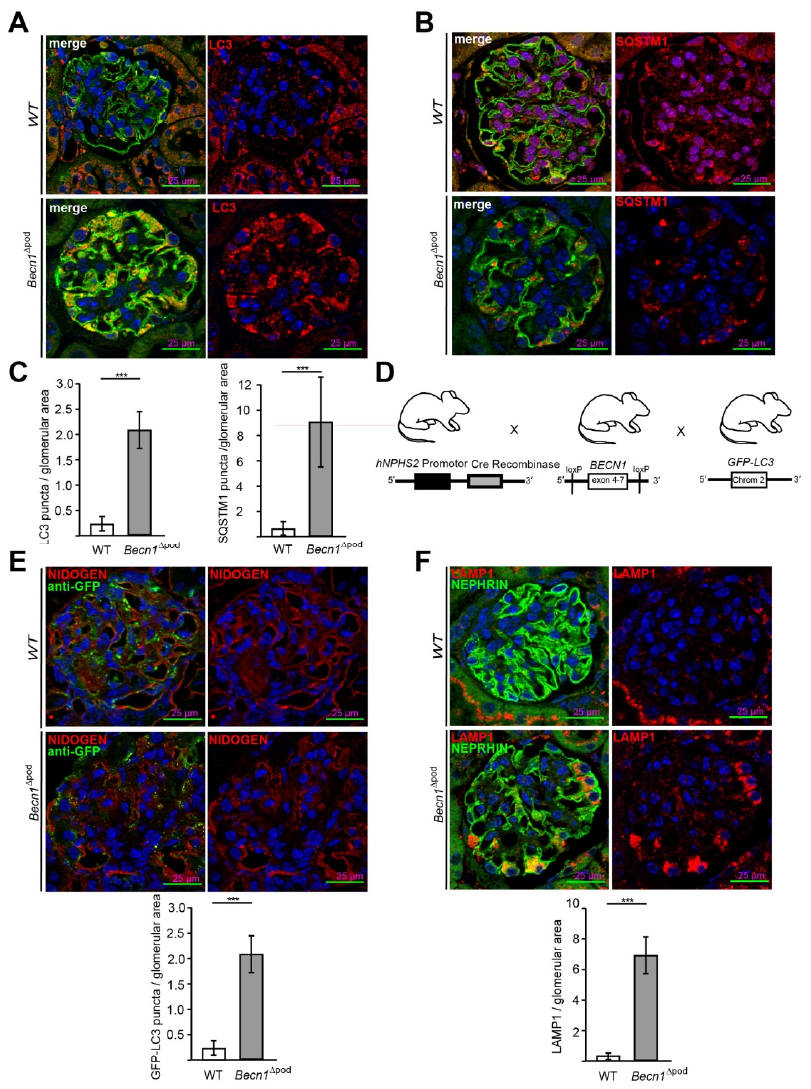
Figure 3. Becn1 ∆ pod mice displaying a high number of autophagosomes with an increased lysosomal compartment. ( A ) Representative image showing immunofluorescence staining for NEPHRIN (green) and LC3 (red) in kidney sections obtained from 4-week-old WT and Becn1 ∆ pod mice; ( B ) Representative image showing immunofluorescence staining for NEPHRIN (green) and SQSTM1 (red) in kidney sections obtained from 4-week-old WT and Becn1 ∆ pod mice; ( C ) Quantification of LC3 and SQSTM1 aggregates in kidney sections obtained from 4-week-old WT and Becn1 ∆ pod mice (n = 6). ( D ) Schematic showing the generation of mice with podocyte-specific deletion of Becn1 and transgenic mice carrying fluorescence-labelled LC3 ( GFP-LC3 ); ( E ) Representative immunofluorescence staining for NIDOGEN (red) and anti-GFP (green) in kidney sections obtained from 4-week-old GFP-LC3 and GFP-LC3 × Becn1 ∆ pod mice. Quantification of GFP-LC3 puncta (n = 6, *** ≤ 0.001); ( F ) Representative image showing immunofluorescence staining for NEPHRIN (green) and LAMP1 (red) in kidney sections obtained from 4-week-old WT and Becn1 ∆ pod mice. Quantification of the LAMP1 signal (n = 8, *** ≤ 0.001).